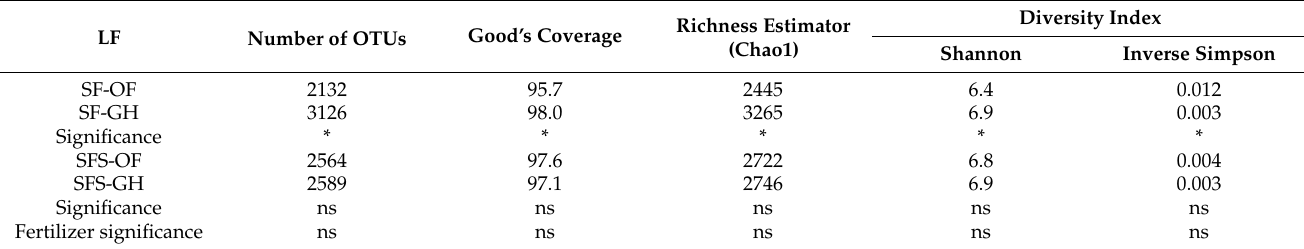
Table 4. Soil bacterial community as affected by starfish (SF)- and starfish + seaweed (SFS)-liquid fertilizers applied in open-field (OF) and greenhouse (GH) cultivated red peppers.